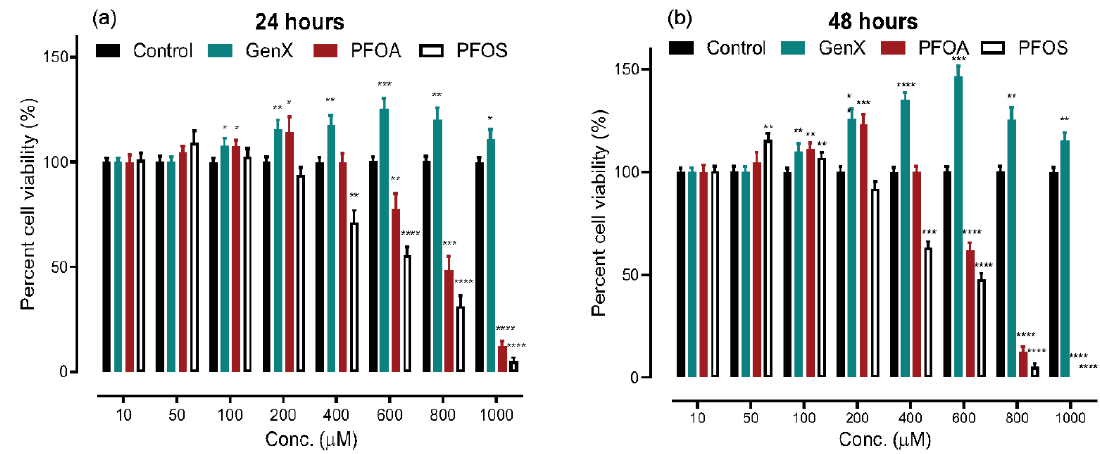
Figure 1. Cytotoxicity evaluation of A549 cells exposed to GenX, perfluorooctanoic acid (PFOA) and perfluorooctane sulfonic acid (PFOS) through 3-(4,5-Dimethylthiazol-2-yl)-2,5-Diphenyltetrazolium Bromide (MTT) assay. ( a ) 24-h exposure time. ( b ) 48-h exposure time. We observed a similar pattern from cell viability analysis, but an exaggerated response in 48-h exposed cells. GenX increases cellular proliferation beyond 50 µ M concentration. PFOA and PFOS show a characteristic significant increase in proliferation at 100- to 200 µ M concentration, but a decrease in viability beyond 200 µ M (PFOS > PFOA). The data are given as the mean ± S.D. for three independent experiments (n = 3) (* = p < 0.05, ** = p < 0.005, *** = p < 0.001, **** = p <